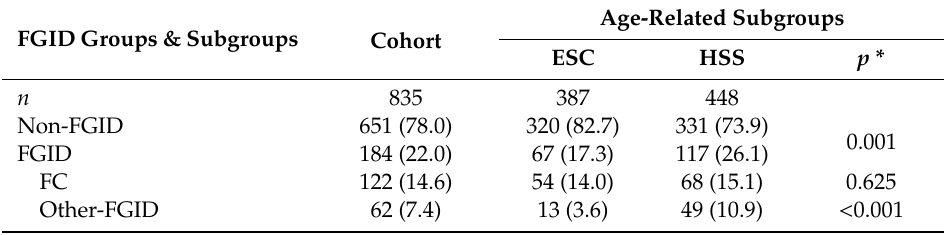
Table 1. Prevalence ( n (percent)) of functional gastrointestinal disorders (FGIDs) in the cohort and the two age-related